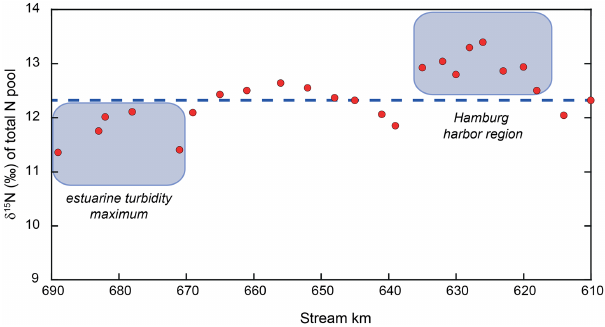
Figure 5. N concentration along the estuary. Total N fluctuations are driven by PN fluctuations. Light blue represents the calculated concentration of particulate matter that is assumed to satisfy mass balance.